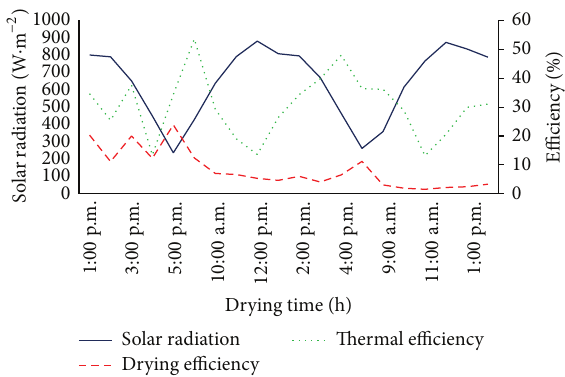
Figure2:Airtemperatures,airrelativehumidity,andsolarradiation patterns during typical drying experiment.